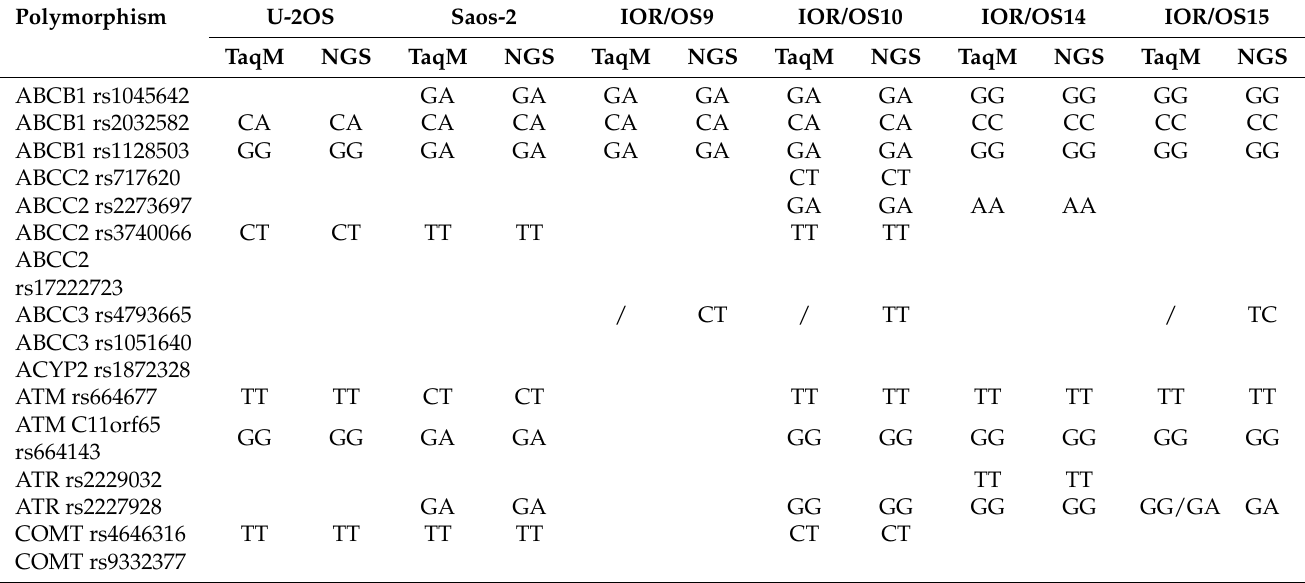
Table 1. Variants of 28 polymorphisms identified in 18 human osteosarcoma cell lines by multimodal targeted next generation sequencing and TaqMan genotyping